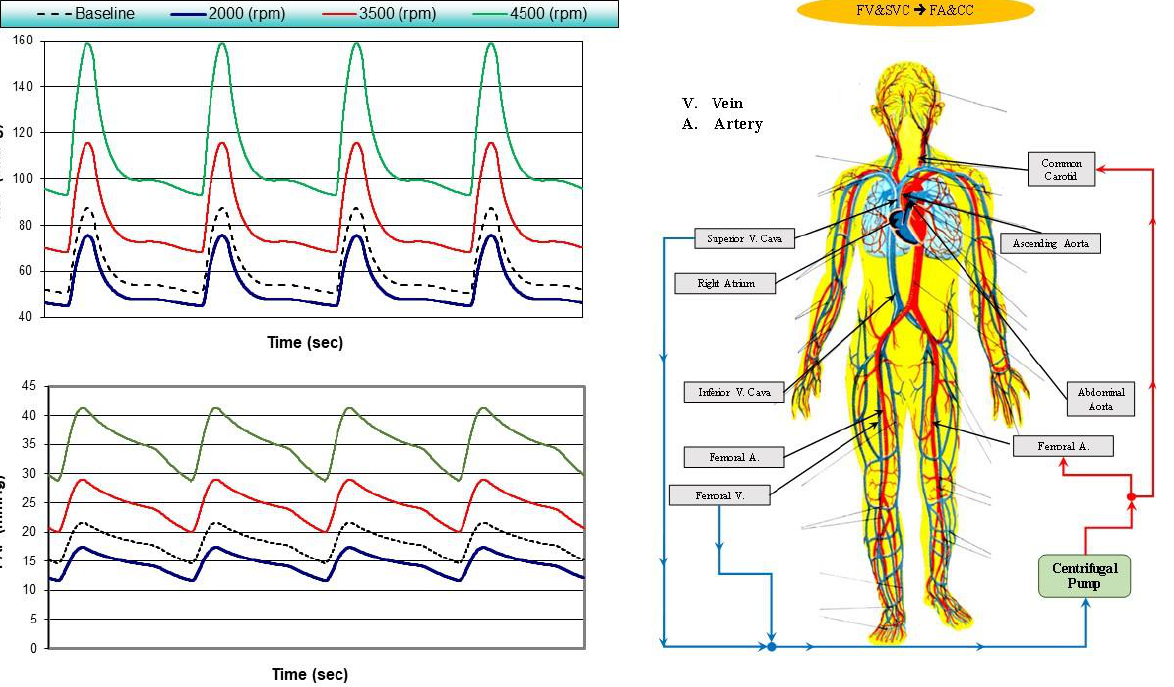
Figure 5. AoP ( top-left panel ) and PAP ( bottom-left panel ) waveforms obtained in baseline condi- tions and with FV&SVC → FA&CC cannulation when the pump rotational speed was set to 2000, 3500 and 4500 rpm. The ( right panel ) shows the FV&SVC → FA&CC cannulation in which the centrifugal pump has two input cannulae (from superior vena cava and femoral vein) and two output cannulae (to femoral and common carotid arteries).